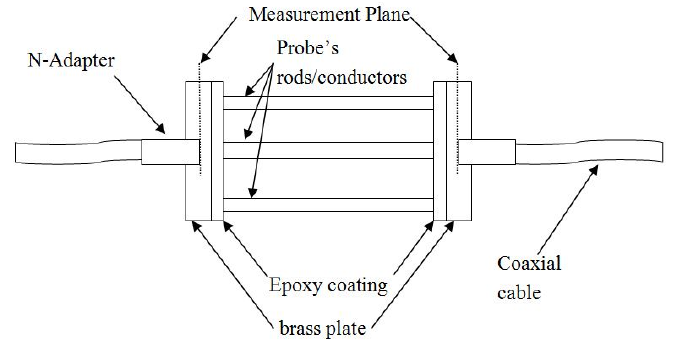
Figure 2. This drawing details the high signal-integrity transition from the soil probe structure to a commercial N-style coaxial adapter that couples with low signal reflections into the interconnecting coaxial cabling. Of importance is to note the location of the measurement plane that is used for calibrating the structure during the short-open-load-through (SOLT) network analyzer calibration protocol.